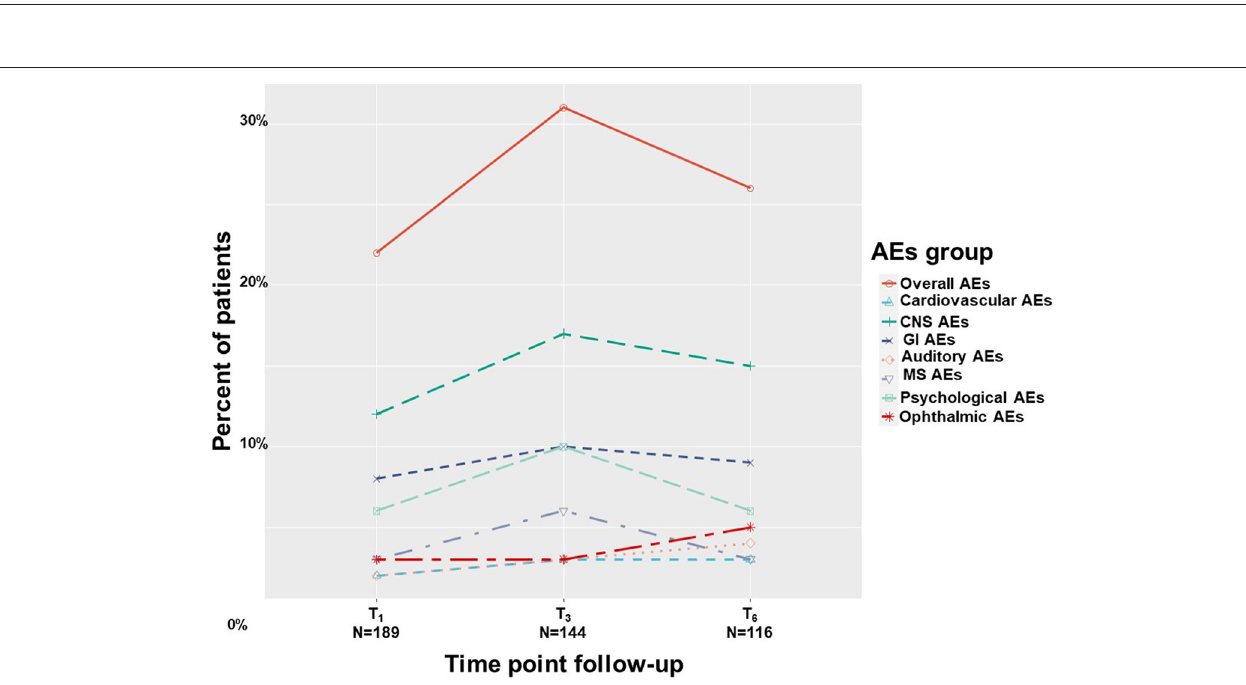
FIGURE 7 | Medical cannabis-related adverse effects. T 1 , 1-month Follow-Up; T 3 , 3-month Follow-Up; T 6 , 6-month Follow-Up; AEs, adverse effects; Overall, at least one AE report; CNS, central nervous system; GI, gastrointestinal; MS, musculoskeletal.